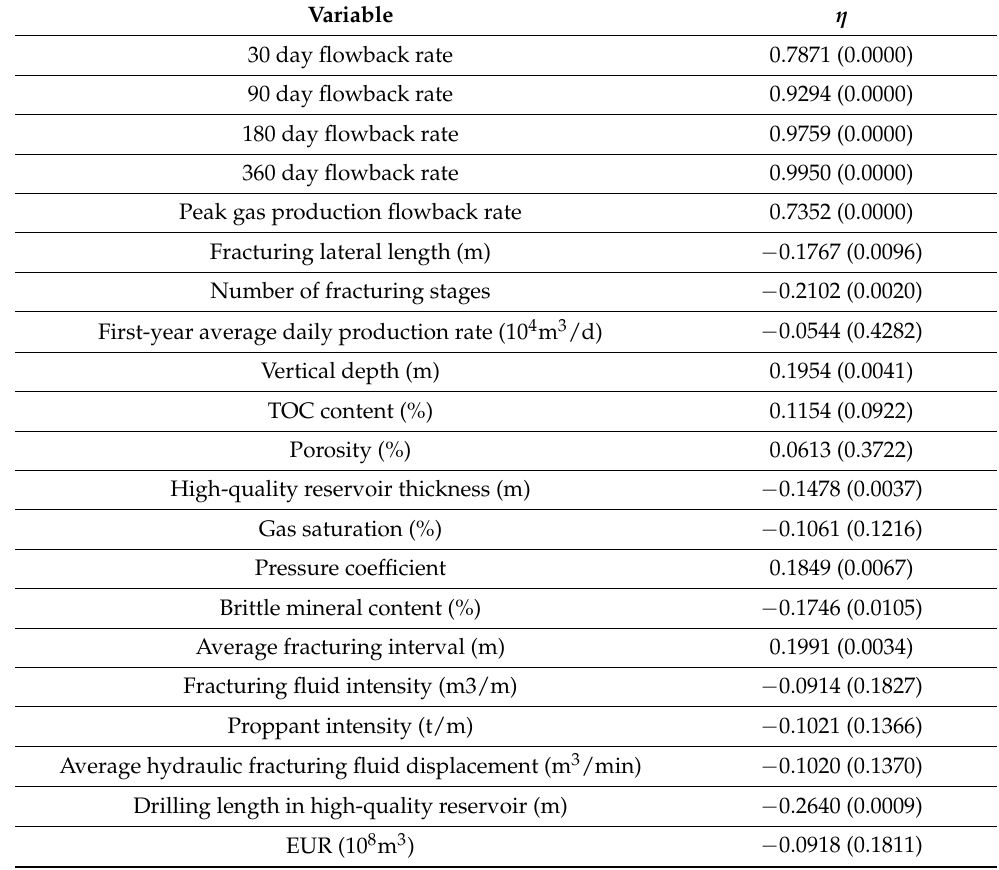
Table 4. Correlations between η and static